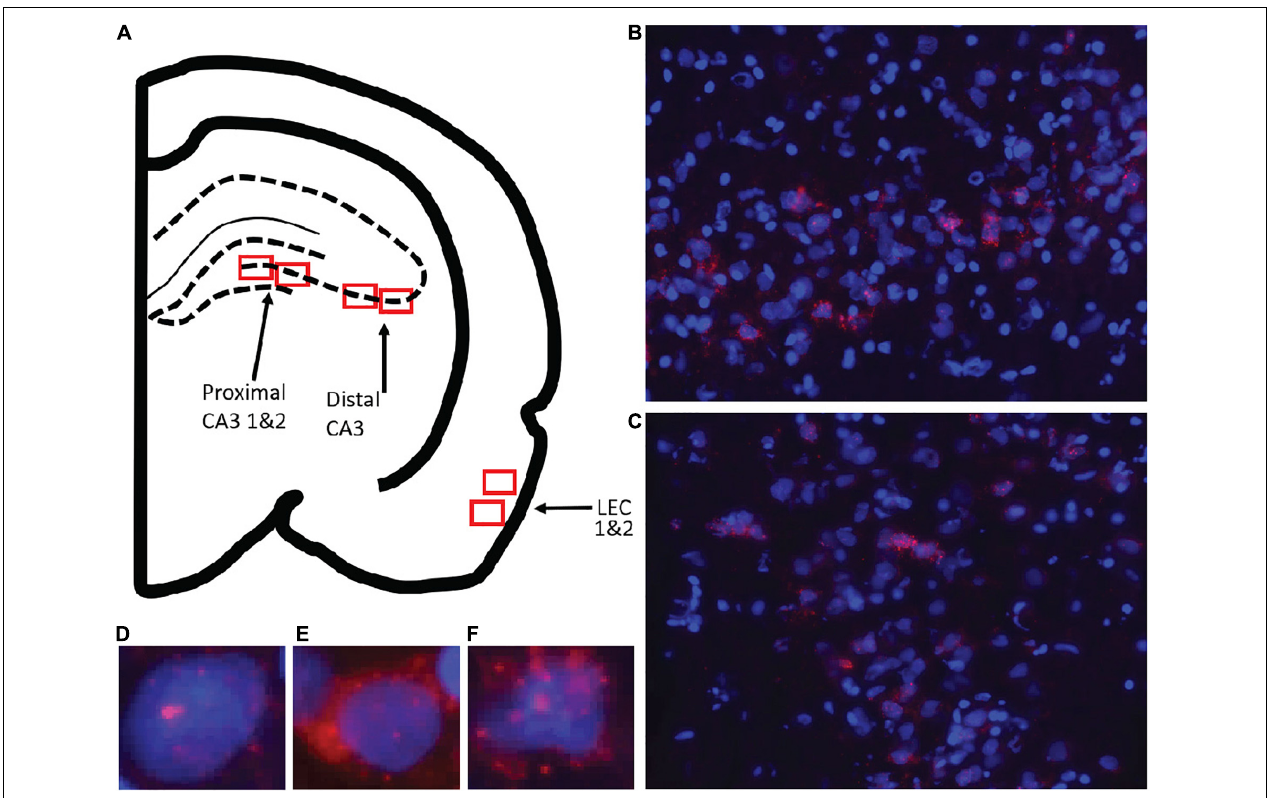
FIGURE 3 | Images taken for analysis of immediate early gene Arc expression in CA3 (proximal, distal) and lateral entorhinal cortex (LEC). (A) Schematic of the locations for image collection. Two areas were sampled from each region of interest shown by the red boxes. (B) Example image of CA3 and (C) LEC analyzed for Arc expression. Overall cell count was determined, and cells were then classified as being positive for Arc in the nucleus or foci (D) , cytoplasm (E) , or both foci and cytoplasm (F)